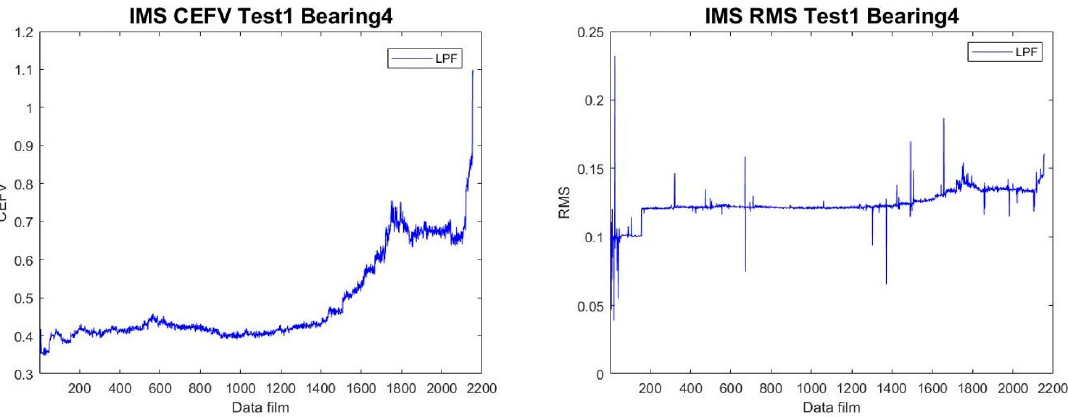
Figure 2. Comparison of CEFV and RMS HI trends.